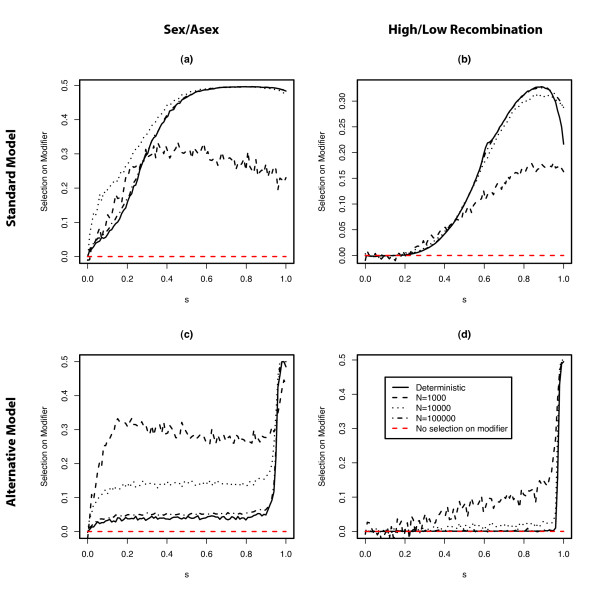
Selective advantage of sexual over asexual reproduction (rmm = 0, rmM = 0, rMM = 0.1) (a,c) and of high over low recombination (b,d) in both the standard model (a,b) and the sequential-updating model (c,d), plotted for different selection coefficients (s) and different population sizes. The y-axis corresponds to the selection on the modifier (of sex/recombination), which is measured as the frequency change during a simulation run (i.e. 1000 host generations after introduction of the modifier allele M), averaged over 10000 simulation runs (100 for the deterministic model) with different random initial conditions.